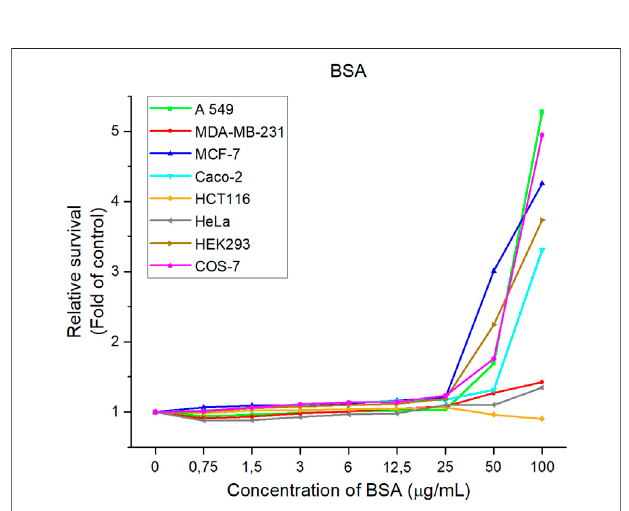
FIGURE 13 | Relative cell line survival after treatment with concentration range of CuS-BSA nanosuspension. The data are presented from